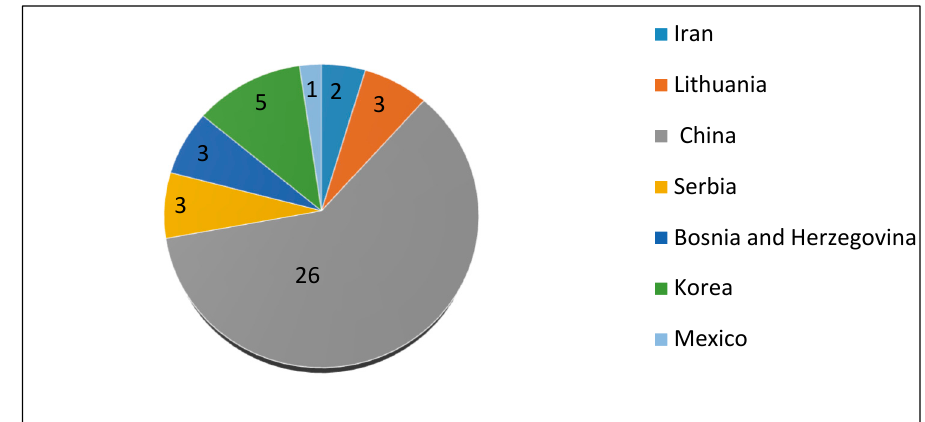
Figure 1. Distribution of authors by country.